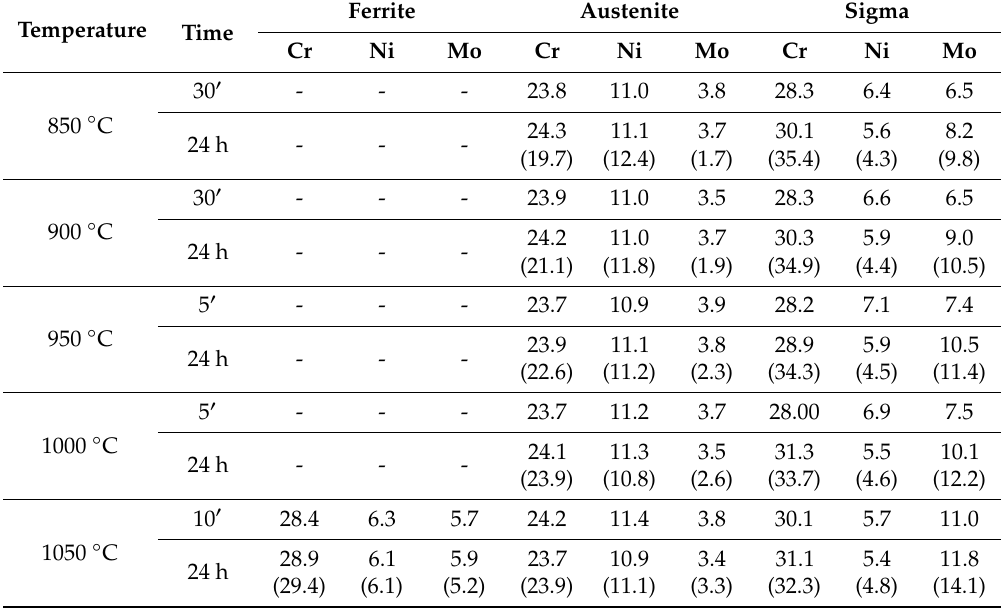
Table 5. EDS phases chemical composition at di ff erent temperatures and soaking times and Thermo-Calc calculated composition (bold between brackets).